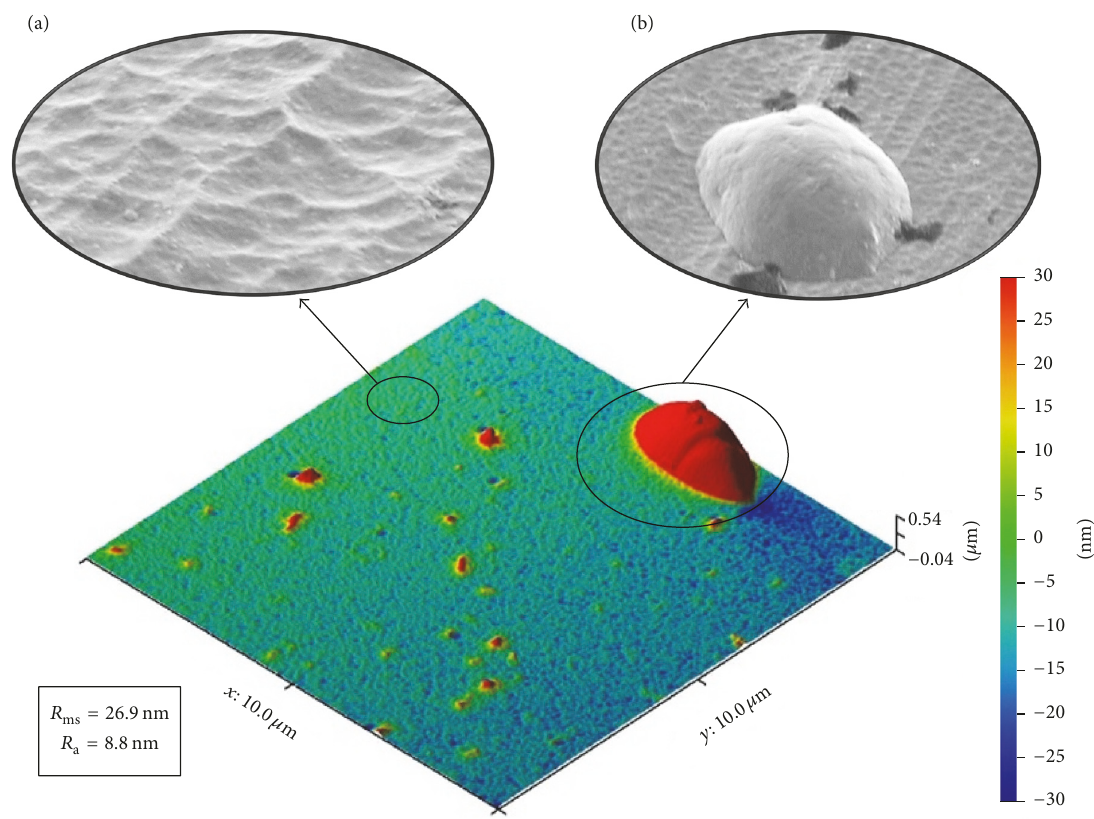
Figure 16: AFM image of the AlTiN coating surface deposited at 500 Hz for a scanned area of 10 × 10 𝜇 m with a maximal structure height of 542 nm (droplet) and a maximal structure depth of − 37 nm. The SEM image on the left (a) illustrates the surface structure in the nanometre range as an example for the marked surface area. The SEM image on the right (b) shows a comparable sized and formed droplet like in the red coloured region in the AFM